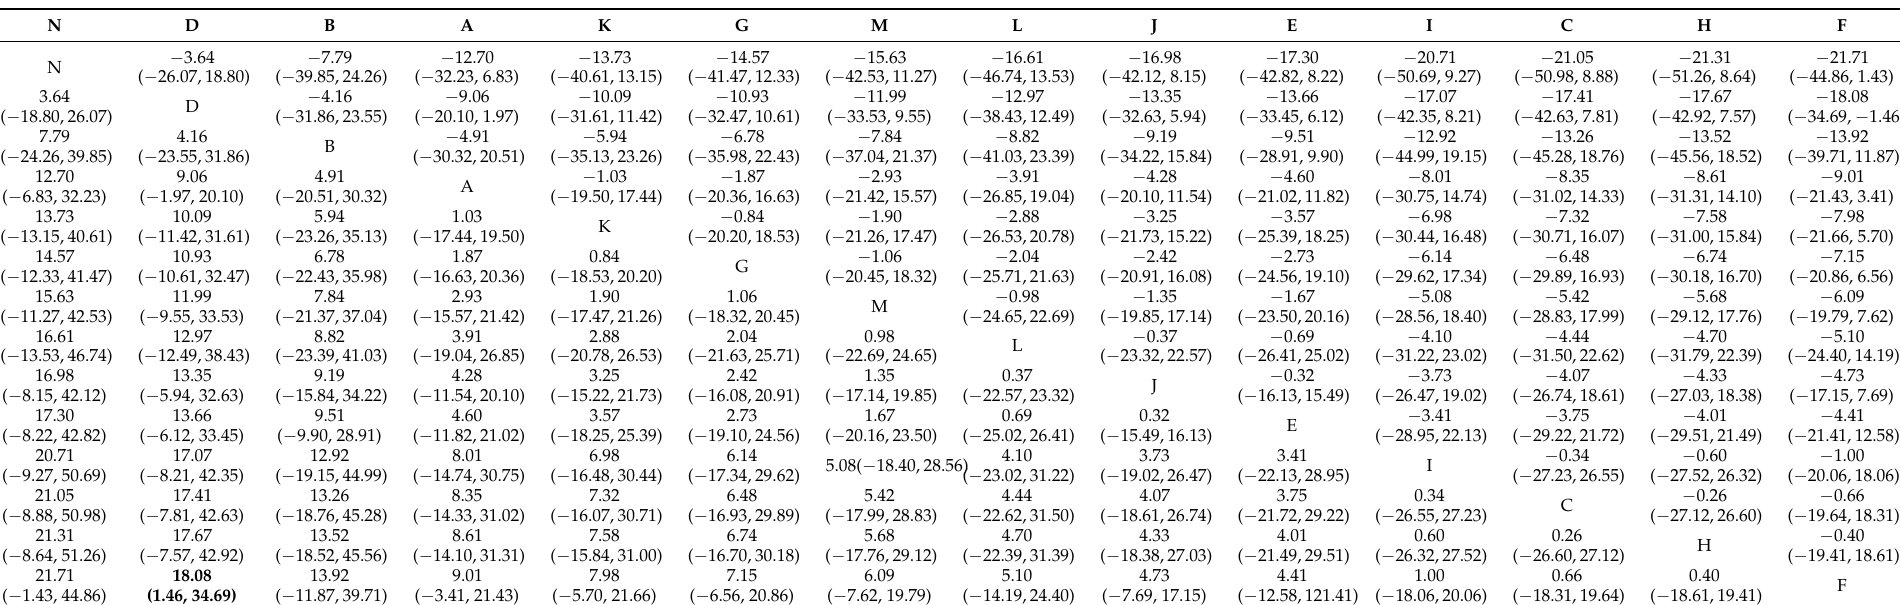
Table 4. Network analysis results of the oral expression